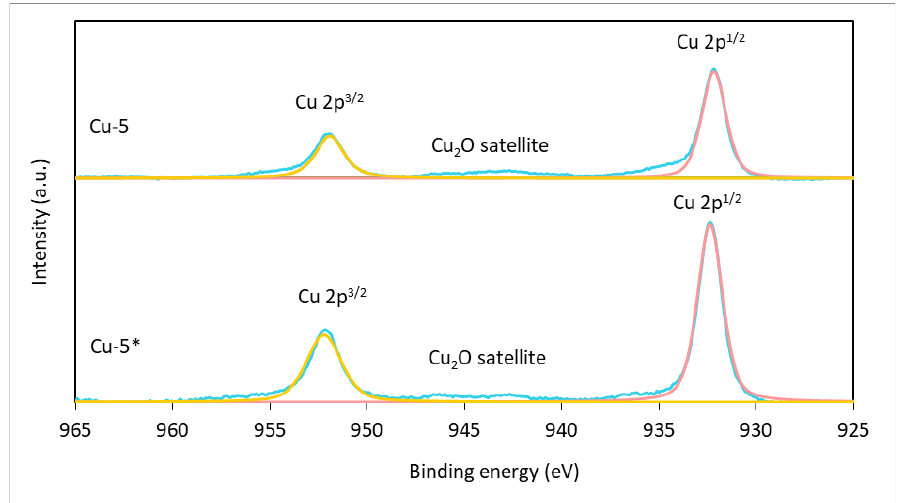
Figure 8. The XPS patterns of copper catalysts (Cu-5*, Cu-5) generated in situ in the reaction medium during hydrogenolysis of glycerol. Blue color: the measured XPS spectrum; pink color: Cu 2p 1/2 region; yellow color: Cu 2p 3/2 region.